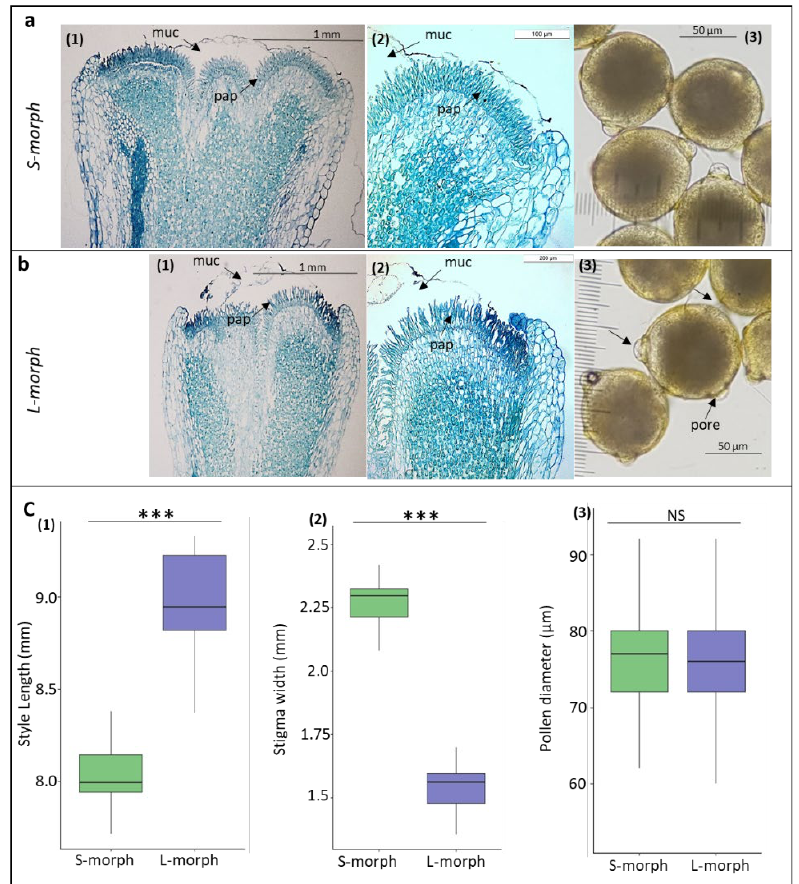
Figure 1: Stigma and pollen morphologies in both floral morphs of Ludwigia grandiflora subsp. hexapetala . Stigma section of S-morph (a 1, 2) and L-morph (b 1, 2) under the 10x (a1, b1) and 20x